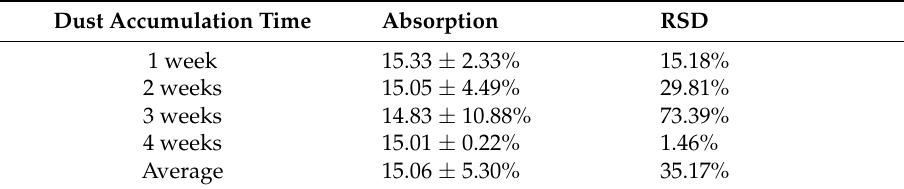
Table 7. Light absorption at 365 nm by dust